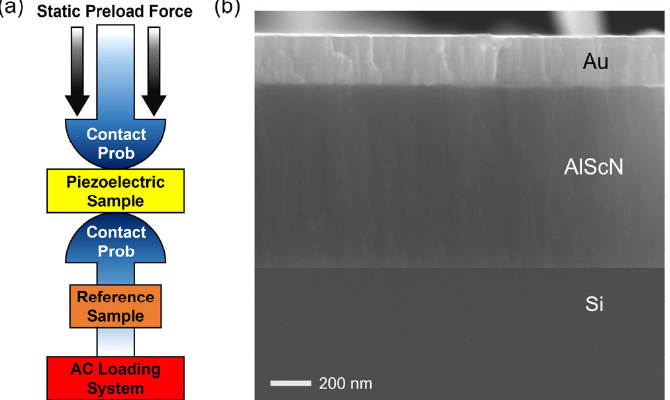
Figure 8. ( a ) Schematic of d 33 measurement by PIEZOTEST PM300 [36]; ( b ) Cross-section SEM image of piezoelectric sample.